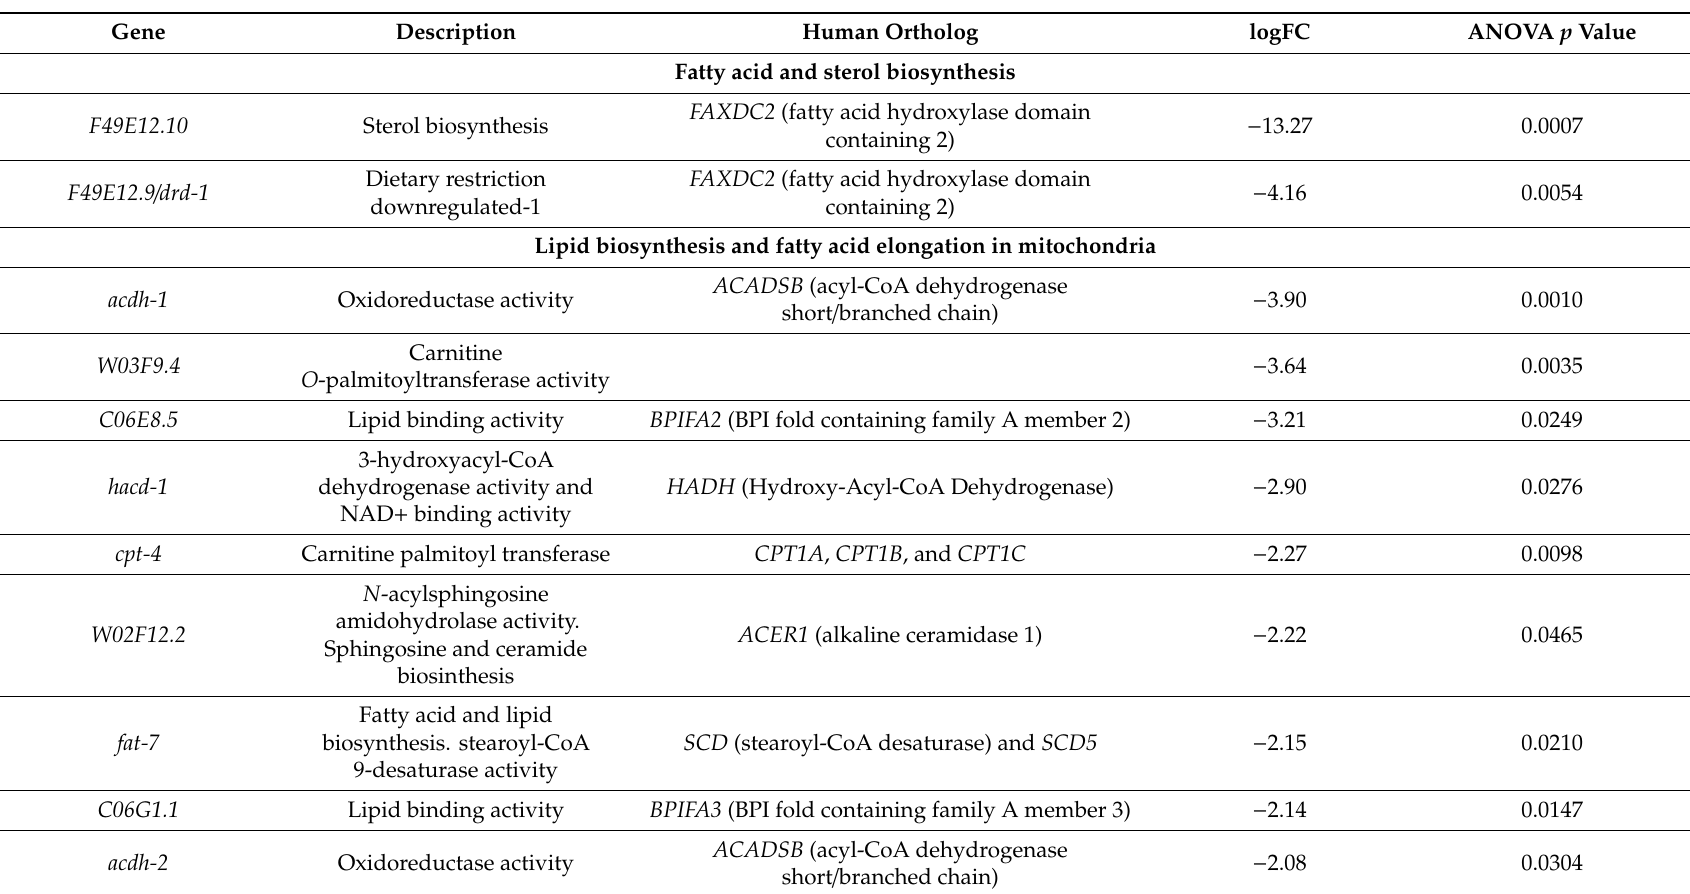
Table 3. Most a ff ected genes involved in lipid and carbohydrate metabolism after treatment with